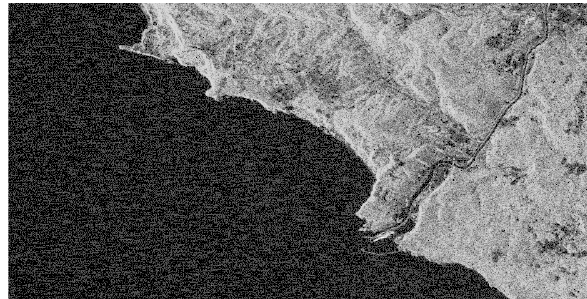
Figure 3. Histogram equalization applied image